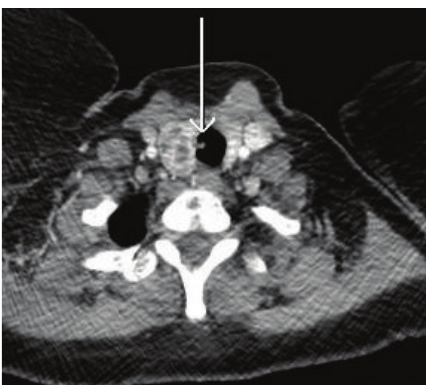
Figure 1: Computed tomography scan demonstrating a peduncu- lated lesion (arrow) projecting from the right tracheal wall into its lumen.